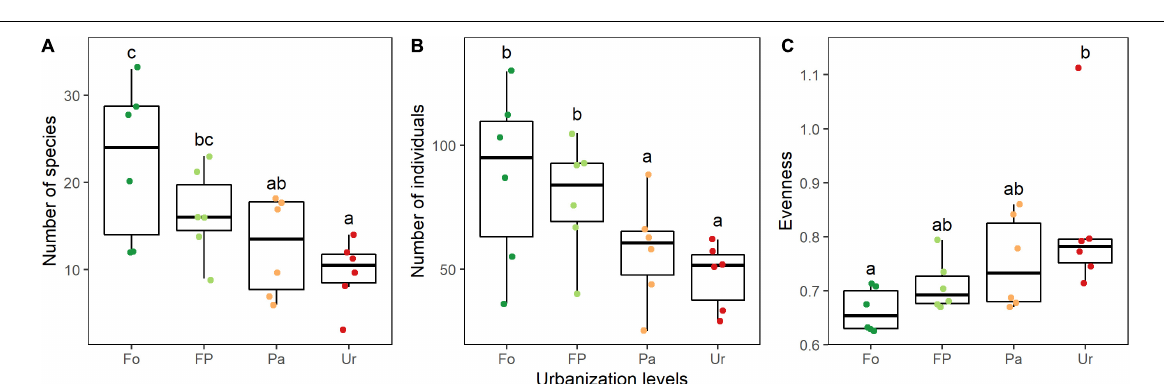
FIGURE 2 | Rarefaction curves (solid lines) for species richness calculated by using the Chao2 estimator with 95% confidence intervals (shaded areas) for the four land-use types along an urbanization gradient in the southern Ecuadorian Andes.